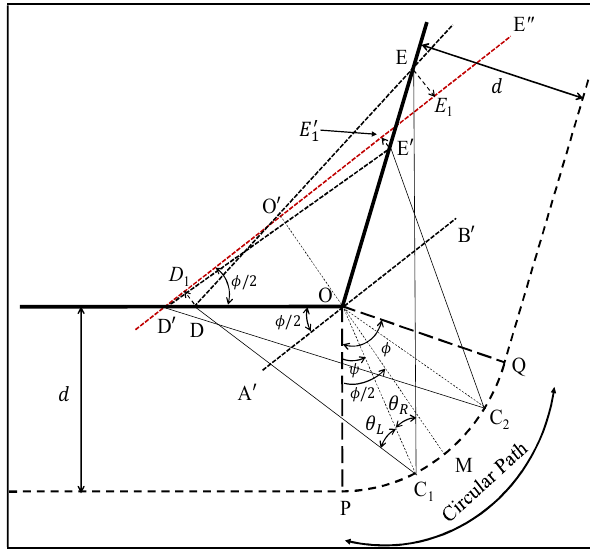
Figure 3. Figure showing overlap between convergent images acquired on circular path According to proposed method, the image width of each convergent image is projected on a line parallel to line A B   , which passes through point O and makes an angle of 2  with both wall planes. Also, this line is divided in two equal parts by a line passing through the mid point M of the circular path. The expression of overlap for two convergent images is derived by calculating the common portions of image widths of two convergent images parallel to line A B  